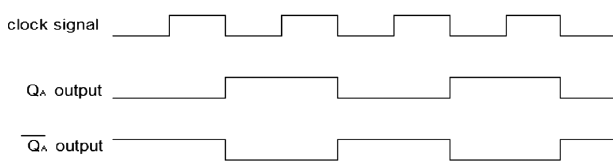
FIG. 38. In the third stage, the signal divider generates gate (cid:2) Q triggers Q A and A for two sets of ICs.